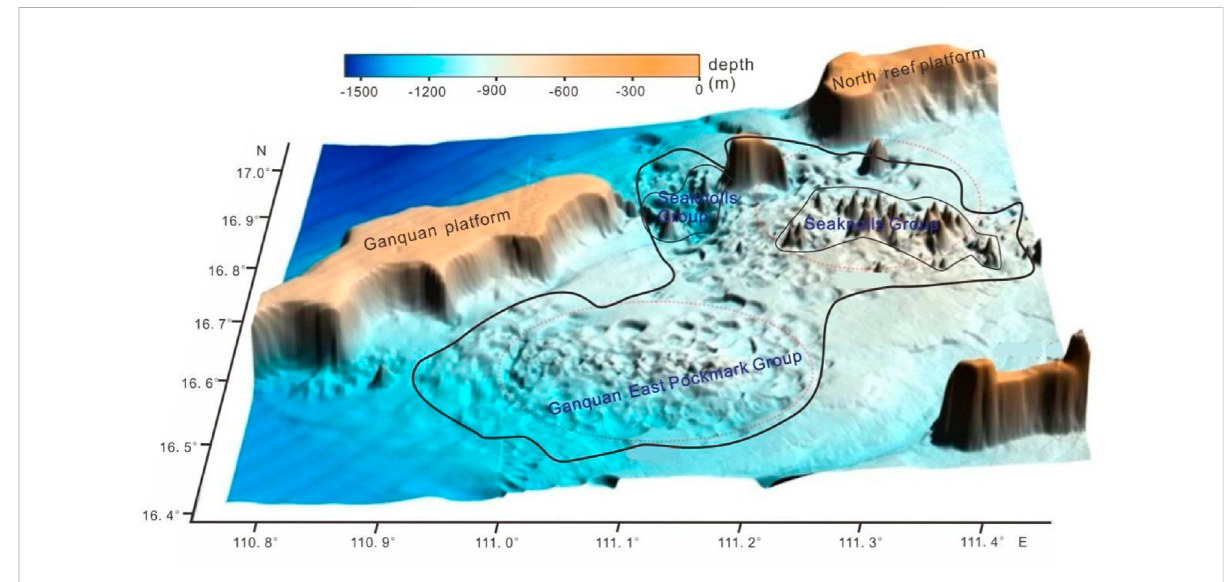
FIGURE 12 Three-dimensional topographic map of the Ganquan East Porkmark Group and Seaknolls Group.